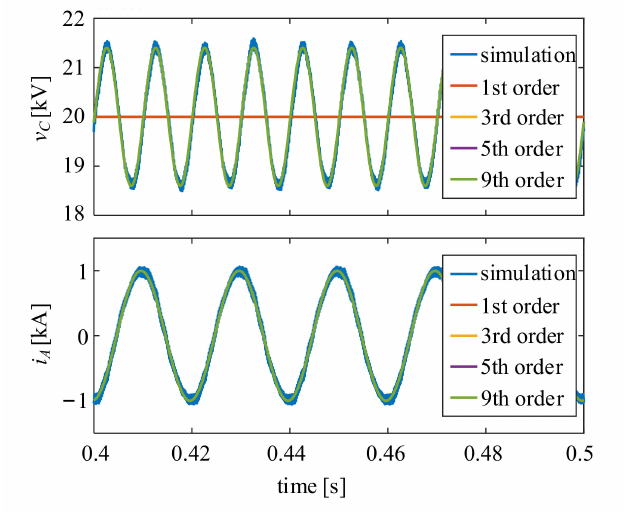
Figure 6. Comparison Between Steady-State Waveforms Obtained with Electromagnetic Transient Simulation and HSS Models of Various Orders.